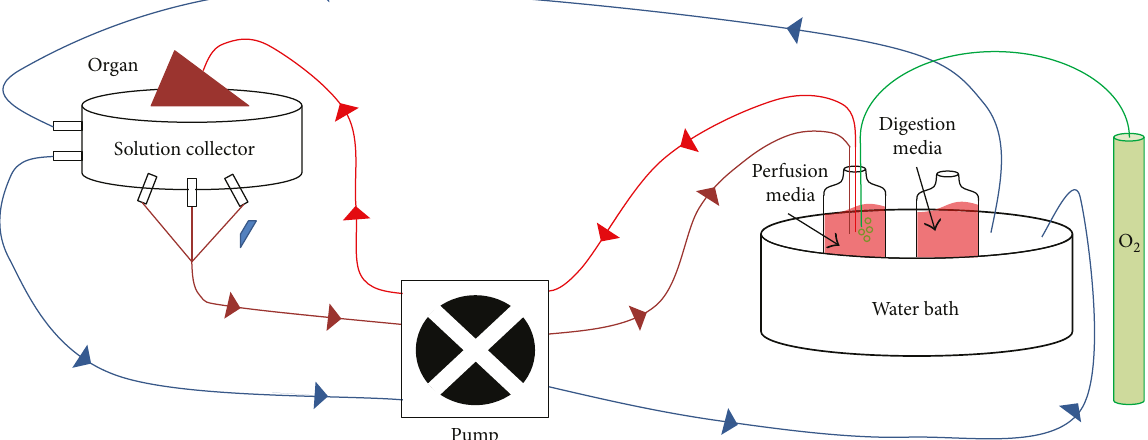
Figure 1: Liver perfusion and digestion system. The isolated liver is maintained at 37 ° C by water circulation (in blue) supplied by a water bath kept at 37 ° C. Perfusion and digestion media are maintained at 37 ° C and oxygenated through the oxygen cylinder (in green). Thereafter, infusion of perfusion media followed by digestion media (in red) into the liver is performed via the vena cava. Flow-through of both media (in brown) is recovered and